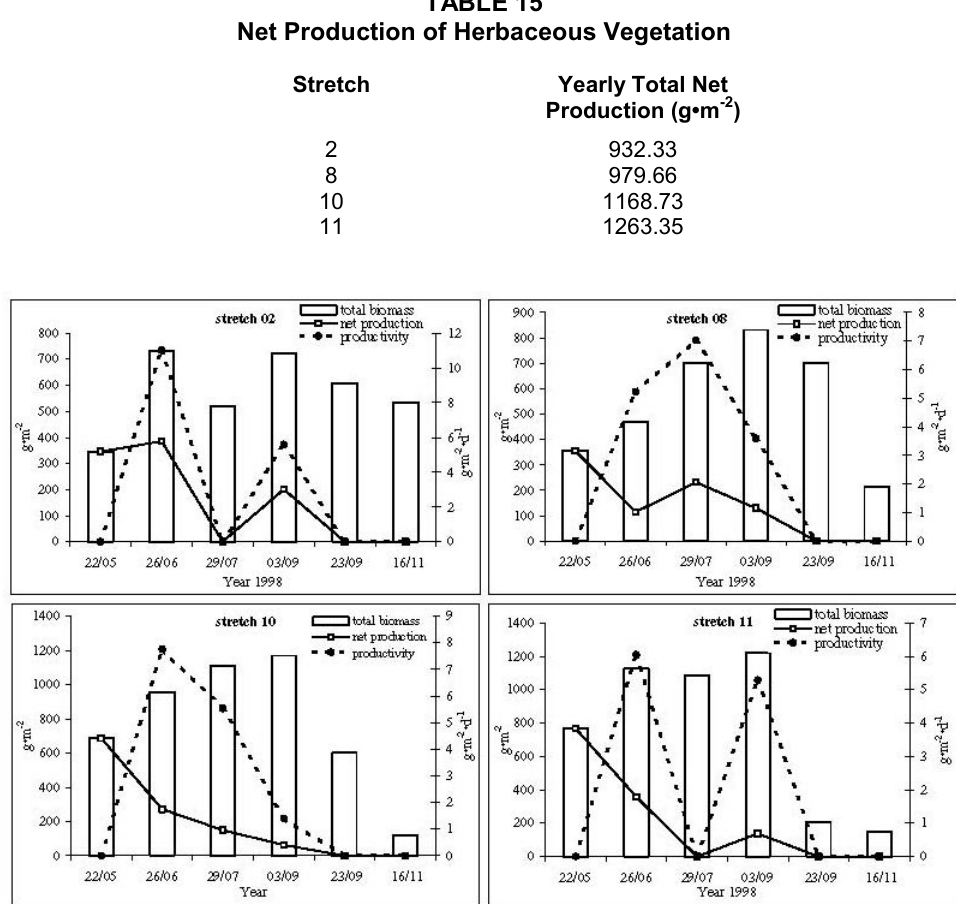
FIGURE 6. Primary production trends for herbaceous vegetation in the four sampling